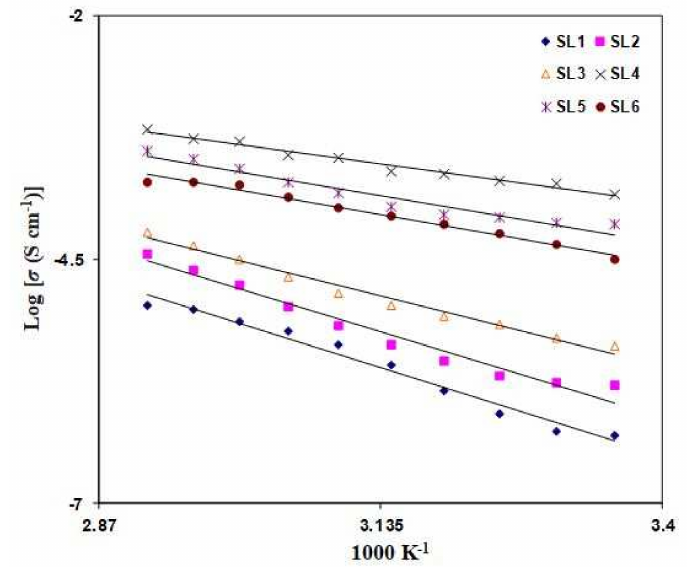
Figure 4. Conductivity at various temperatures for the salted